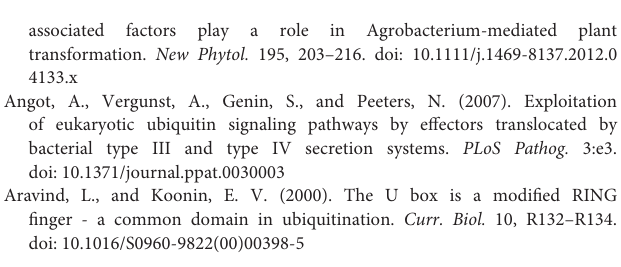
Supplementary Table 2 | The nucleotide sequences of primers used in pull down assay. Supplementary Table 3 | GmPUB gene expression levels during